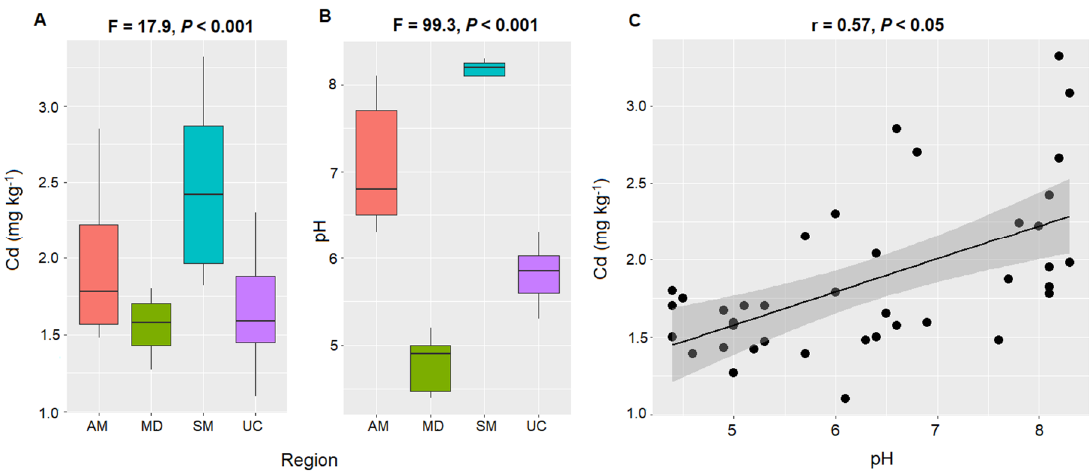
Figure 3. Boxplots of cadmium (Cd, mg kg − 1 ) in the soil ( A ) and soil pH ( B ) for each region ( n = 40). Regions: Madre de Dios (MD), (UC) Ucayali, San Martin (SM) and Amazonas (AM). ( C ) Relationship between cadmium (Cd, mg kg − 1 ) in the soil and soil pH.